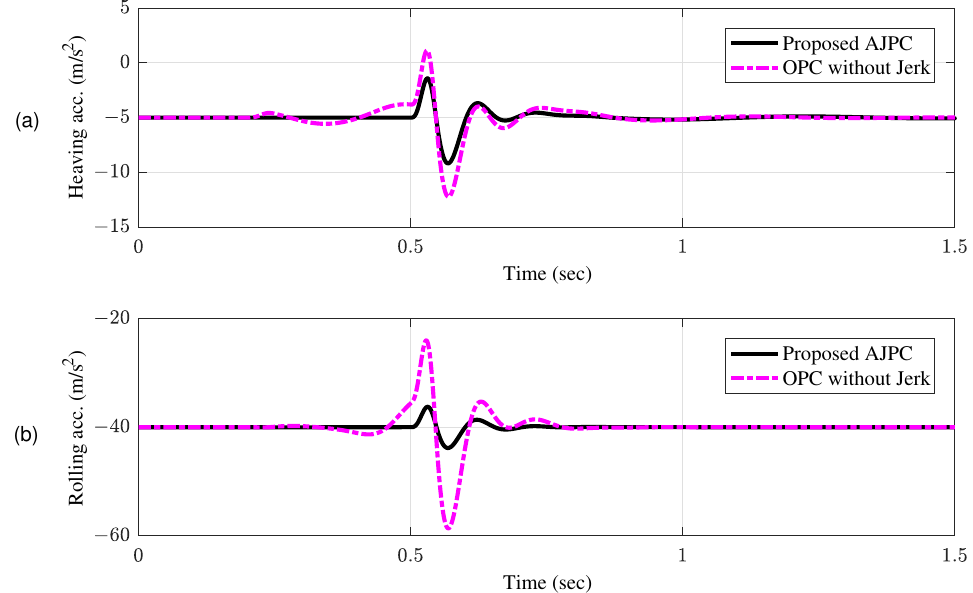
Figure 10. Time domain response of vehicle body acceleration to a bump velocity input using pro- posed AJPC strategy and OPC strategy without jerk; ( a ) heaving acceleration ( b ) rolling